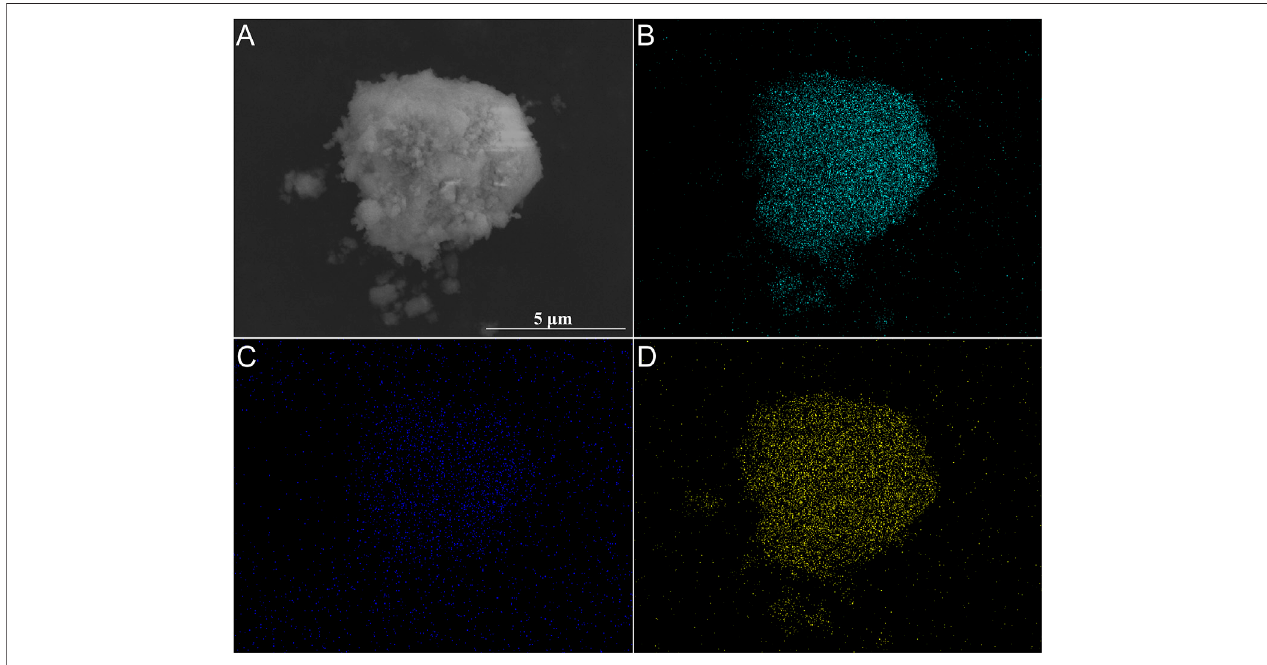
FIGURE10| SEMimage (A) andelementsmapping (B – D) of fi ltrationresiduesobtainedatLa/Fmolarratiosof1:3.00inthepresenceof0.50 g L − 1 Na 2 SiO 3 . (B) F, (C) Si, (D) La.